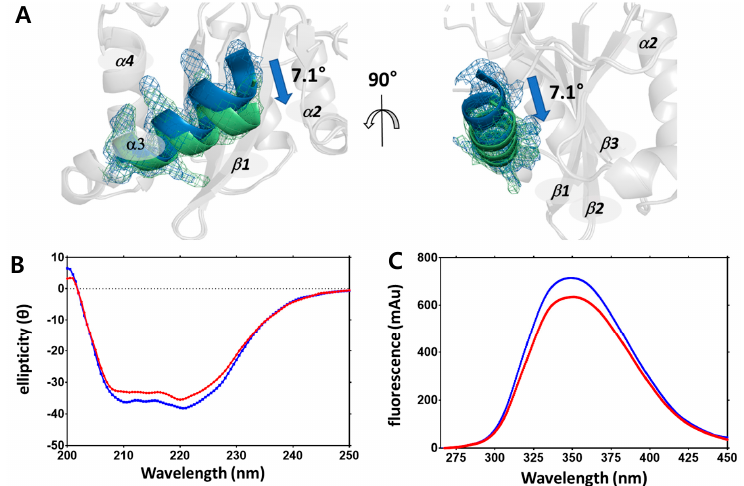
Figure 3. Changes in secondary structure presented by omit maps and circular dichroism and fluorescence absorbance. ( A ) Superimposed helix III region of non-cryogenic (green) and cryogenic (blue) structures plotted using an omit map at contour level 1.5 σ . ( B ) Circular dichroism spectra of HIV-1 integrase catalytic core domain at 4 °C (blue) and 25 °C (red). ( C ) Fluorescence intensity absorbance of HIV-1 integrase catalytic core domain at 4 °C (blue) and 25 °C (red).